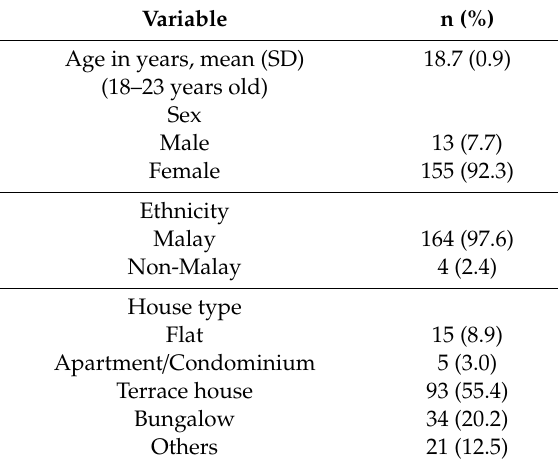
Table 1. Demographic characteristics of the participants (n =